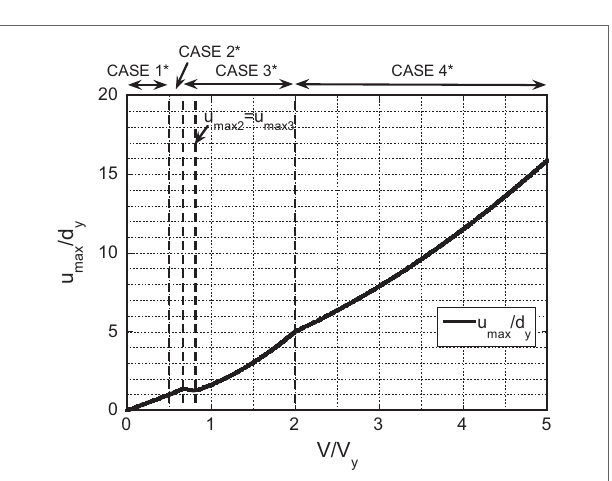
FigUre 5 | Modified version of timing of the third impulse: (a) case 3, (B) case 4 ( • : first impulse, ▴ : second impulse, ◼ : third impulse)